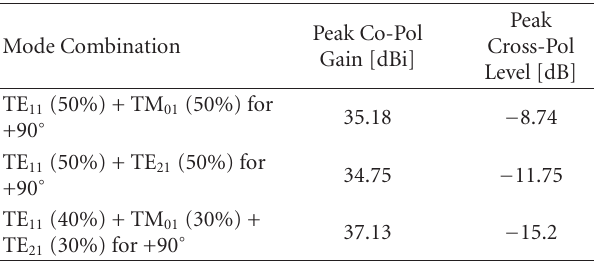
Table 1: Peak copolarization gain and peak cross-polarization level (below peak gain) values at 7.73 GHz with the di ff erent mode combinations. The power to the individual mode is given in percentage.